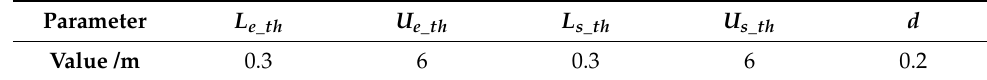
Table 1. Parameter settings of the feature extraction.